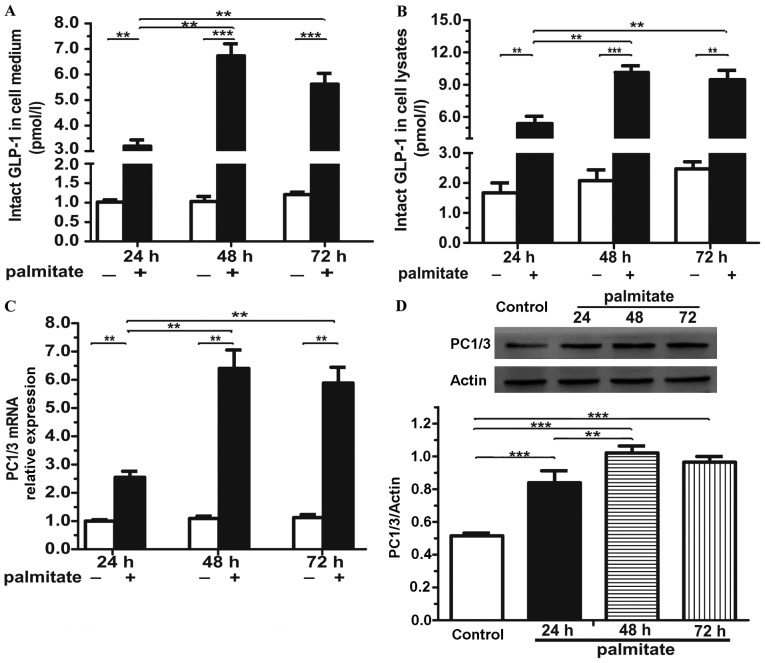
Prolonged exposure to palmitate induces the activation of the glucagon-like peptide-1 (GLP-1) system in isolated mouse islets. After the islet cells were incubated with 0.5 mmol/l palmitate for the indicated periods of time, the GLP-1 levels in the (A) cell medium and (B) lysates were determined by insulin enzyme-linked immunosorbent assay (ELISA), and (C) prohormone convertase 1/3 (PC1/3) mRNA expression in cell lysates was determined by qPCR and (D) the PC1/3 protein level was determined by immunoblot anlaysis. n=3 separate islet preparations; **p<0.01; ***p<0.001.